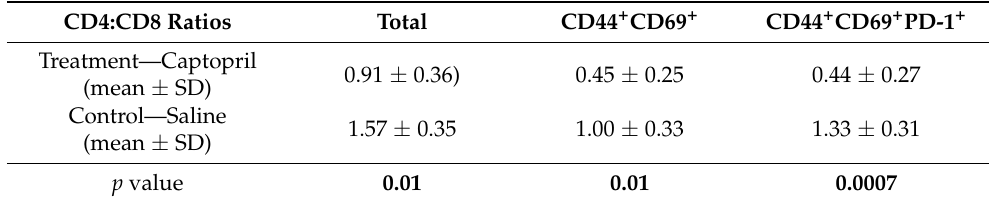
Table 1. Ratios of total CD4 + :CD8 + lymphocytes with their respective ratios for CD44 + CD69 + and CD44 + CD69 + PD-1 + populations in